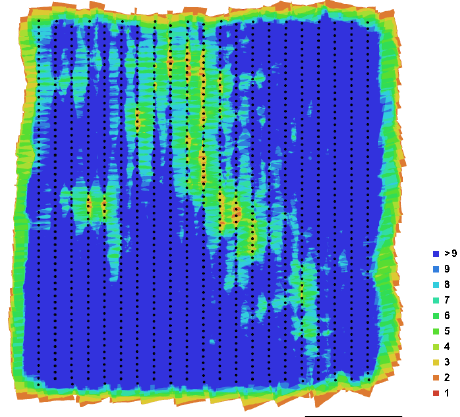
Figure 6. Positions of the exposures and number of image observations of surveying area B Seven ground control points were measured under the WGS84 coordinate system by using the static networked observation method. The absolute accuracy of the ground control points was at the level of decimetres. Figure 7 shows the positions of the ground control points.